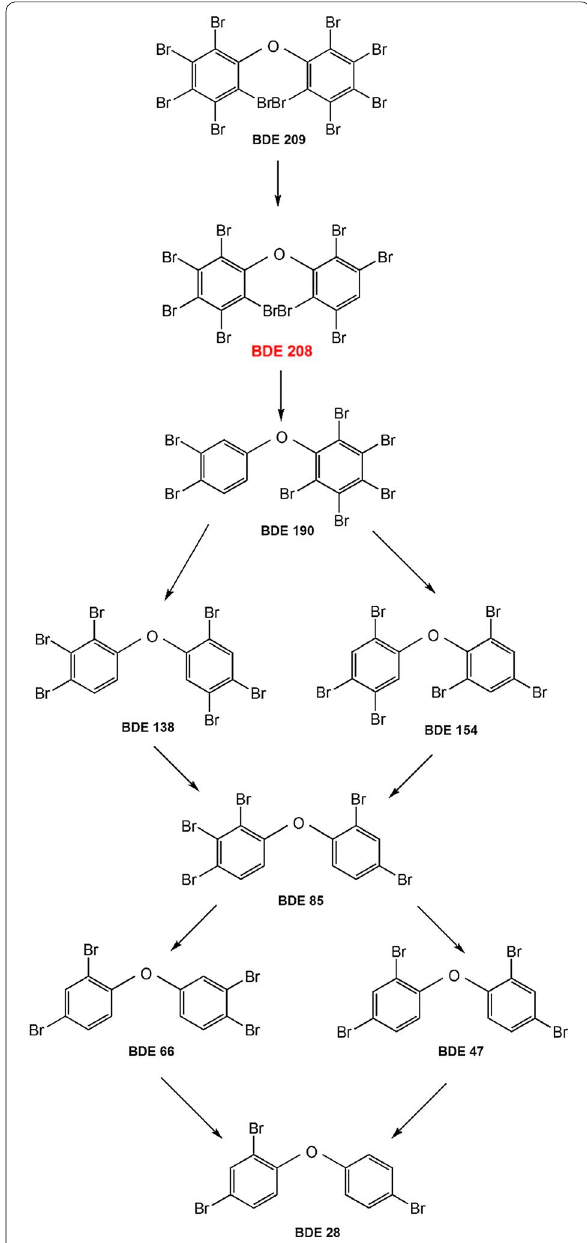
Fig. 3 A proposed debromination pathway for BDE 209 biodegrada- tion by strain